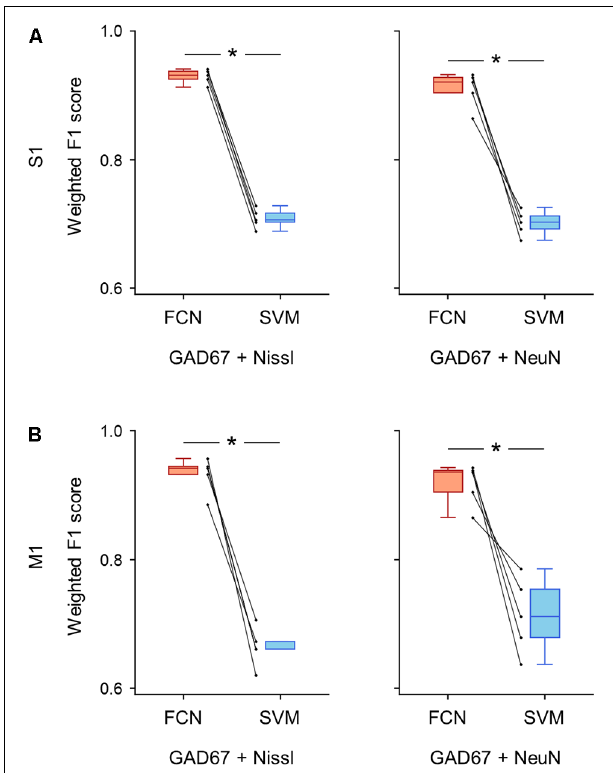
FIGURE 7 | Classification performance of cell images using signal pairs including anti-GAD67 fluorescence. (A) Weighted F1 score of the FCN model (red) and the PCA-SVM classifier (blue) trained on cell images from S1. Each point (gray) signifies the score for cross-validation (5-fold). Left: classification performance using anti-GAD67 and Nissl fluorescence signals. P = 9.9 × 10 –7 , t (4) = 46.9, n = 5-fold cross-validations, paired t -test. * P < 0.05. Right: the same as on the left, but for anti-GAD67 and anti-NeuN immunofluorescence signals. P = 4.1 × 10 –4 , t (4) = 10.8, n = 5-fold cross-validations, paired t -test. * P < 0.05. (B) The same as (A) , but for M1. Left: P = 2.8 × 10 –4 , t (4) = 12.0, n = 5-fold cross-validations, paired t -test. * P < 0.05. Right: P = 6.8 × 10 –3 , t (4) = 5.1, n = 5-fold cross-validations, paired t -test. * P < 0.05. Abbreviations: S1, primary somatosensory cortex; M1, primary motor cortex; FCN, fully convolutional network; SVM, support vector machine; PCA, principal component